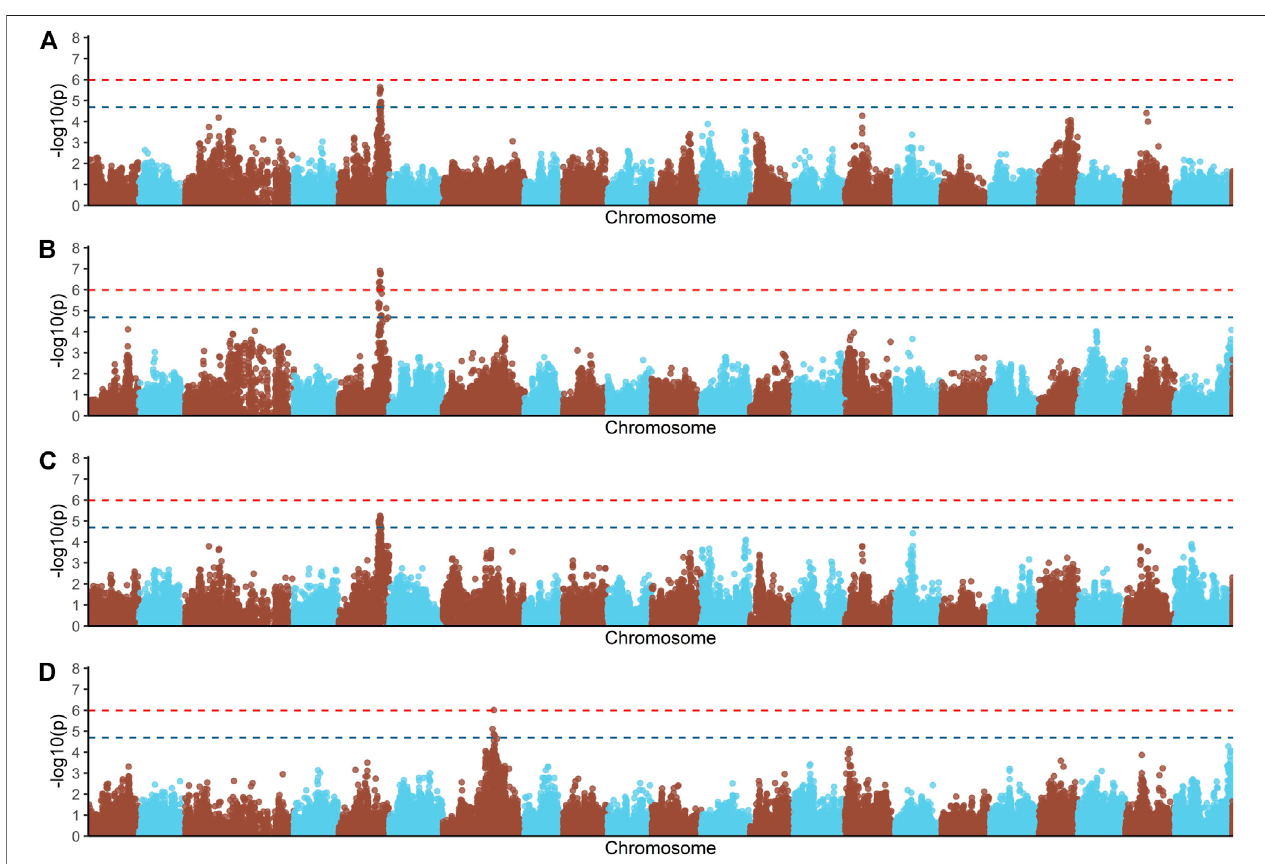
FIGURE 1 | Genome-wide association analysis for feed conversion rate related traits in a Nile tilapia ( Oreochromis niloticus ) breeding population. Genome-wide association analyses for feed conversion ratio (A) , body weight gain (B) , residual feed intake (C) and feed intake (D) . Red and blue dashed line represents the genome- wide and suggestive Bonferroni signi fi cant threshold, respectively.